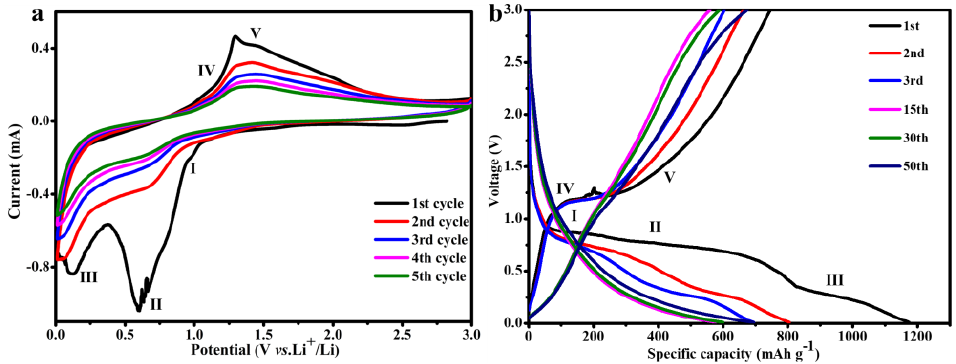
Figure 6. ( a ) The cyclic voltammograms of GO/B-AsP/CNTs at 0.2 mV s −1 . ( b ) The galvanostatic charge-discharge curves of GO/B-AsP/CNTs.